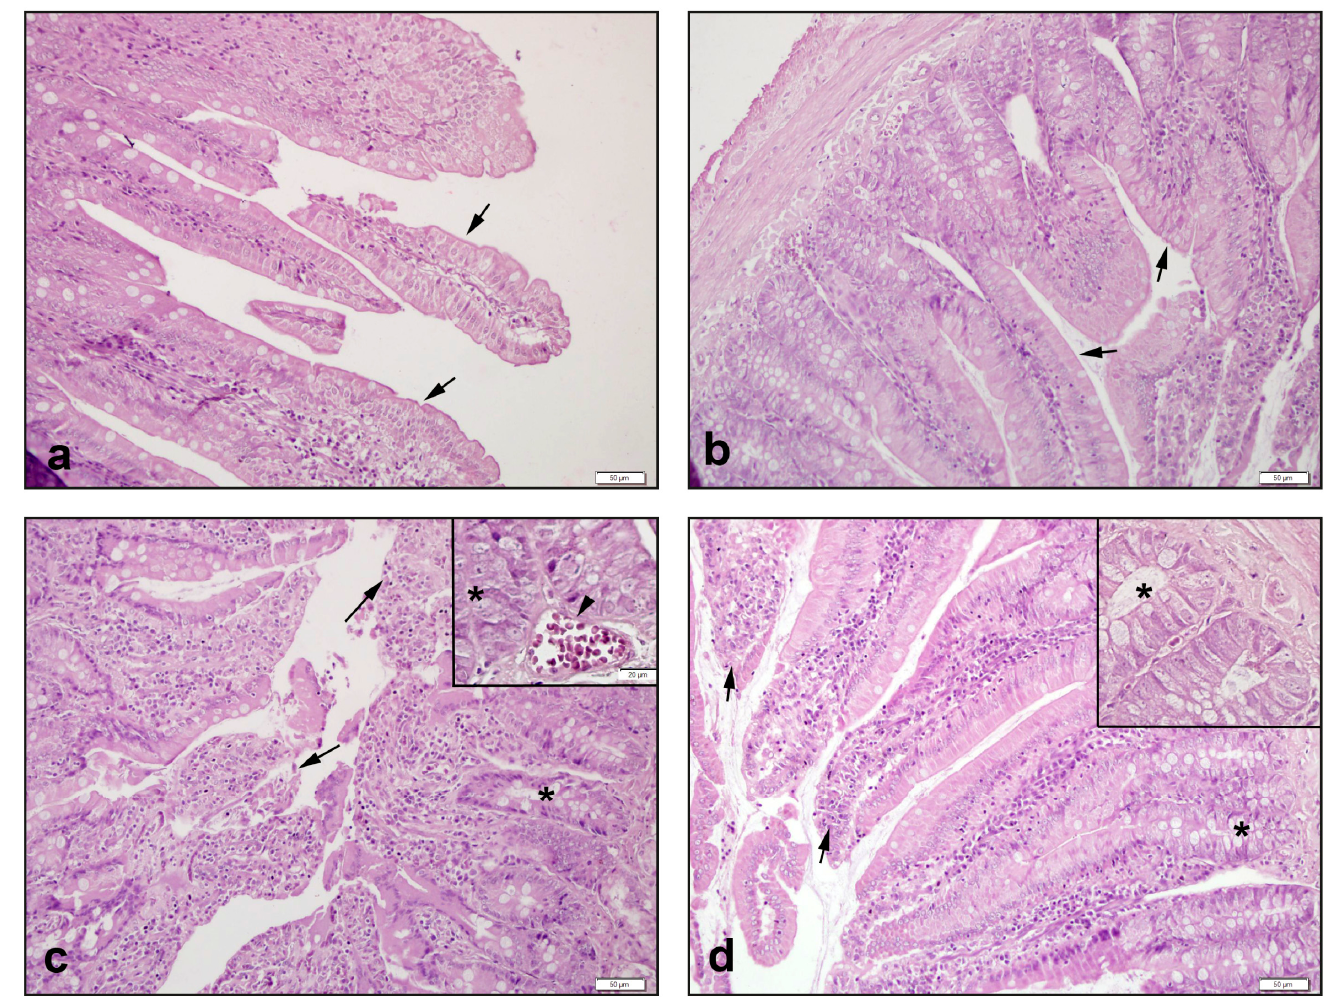
Figure 4. Histological view of small intestine: ( a ) Control group of → : villi structures observed with smooth intestinal epithelial cells; ( b ) NAC group of → : villi with smooth epithelial cells similar to the control group; ( c ) CPT-11 group of *: disruptions in the intestinal glands, and ‣ : capillary con- gestion, and → : severe shedding of epithelial cells in villus structures; ( d ) CPT-11+NAC group of *: regression of disorders in the intestinal glands, and → : healings in villus epithelial cells. Hematox- ylin & Eosin staining, 50 μ m scale bar.